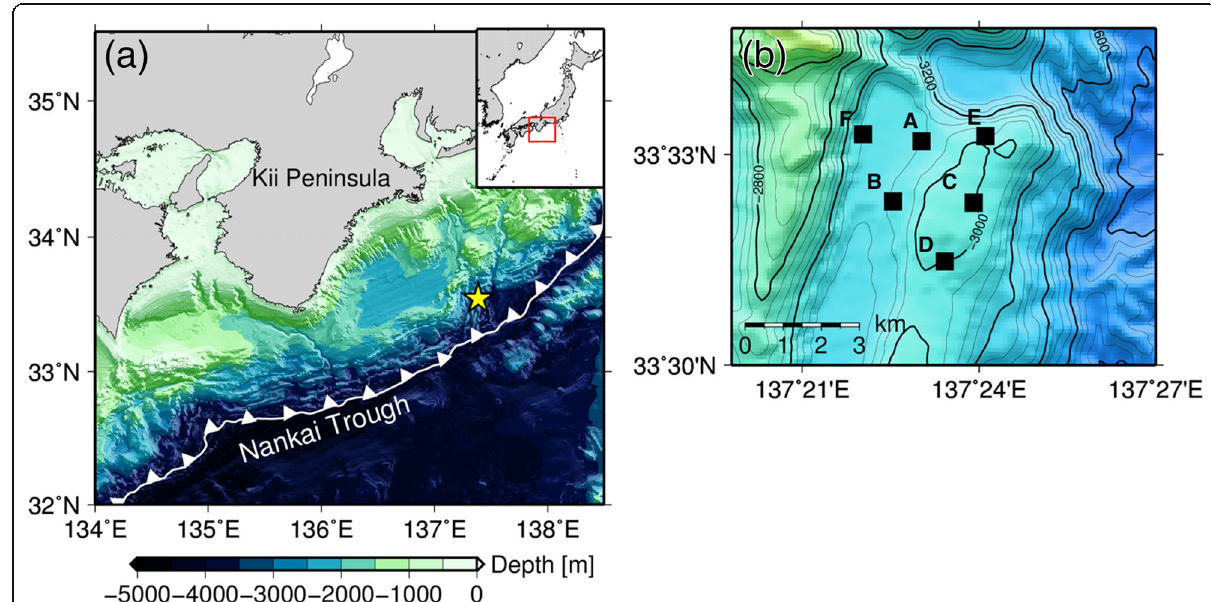
Fig. 2 Location of the GNSS-A site used in our research. a PXPs and the buoy system for GNSS-A observation were installed offshore the Kii Peninsula in the Tokai region of Japan, near the Nankai trough, at a depth of 3000 m (yellow star). b Geometry of six PXPs installed at the observation site in Fig. 2a. The array consists of six PXPs represented by black